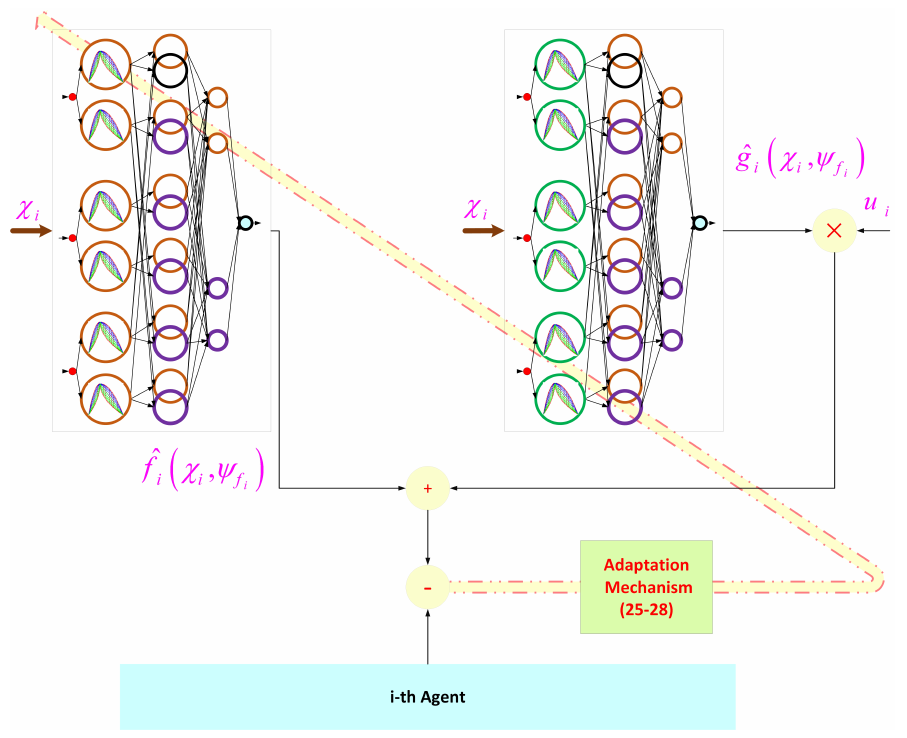
Figure 2. General identification and learning